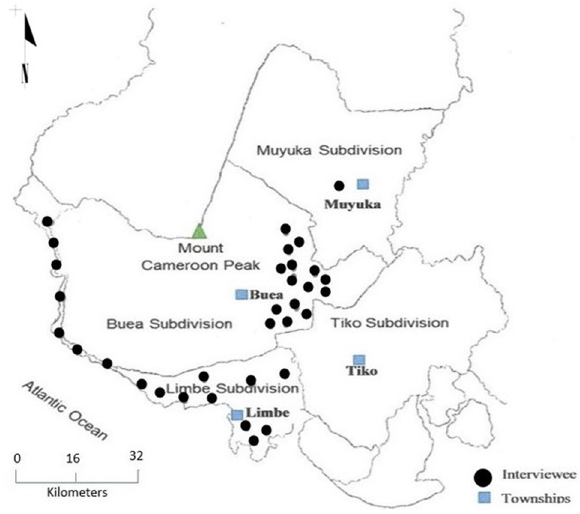
Fig. 2 Map of Fako Division, Cameroon, highlighting interview locations and major